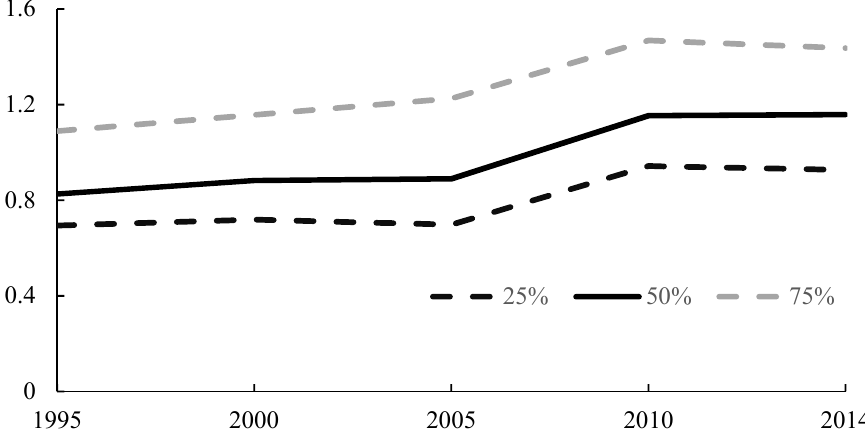
Figure 3. Model 1-based estimates of the temporal trends of urban expansion. The vertical axis legend represents the estimated log LD value of each county in the study area based on the model 1 simulation results. The three lines (75%, 50%, and 25%) represent the upper quantile, median, and lower quantile of estimation results on urban expansion after adjusting for covariate effects from 1994 to 2014.